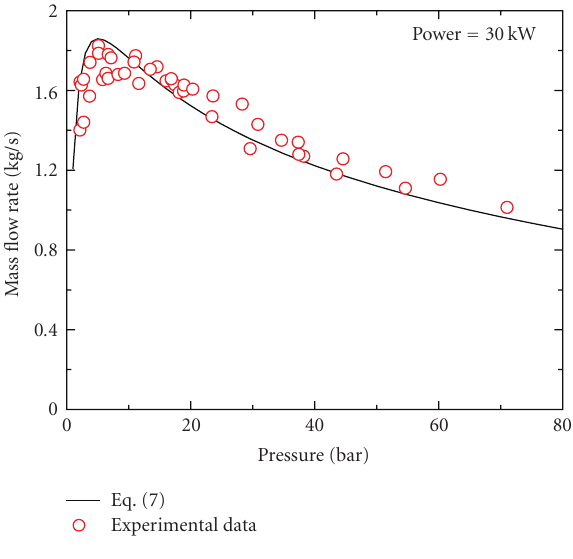
Figure 10: E ff ect of pressure on flow rate.